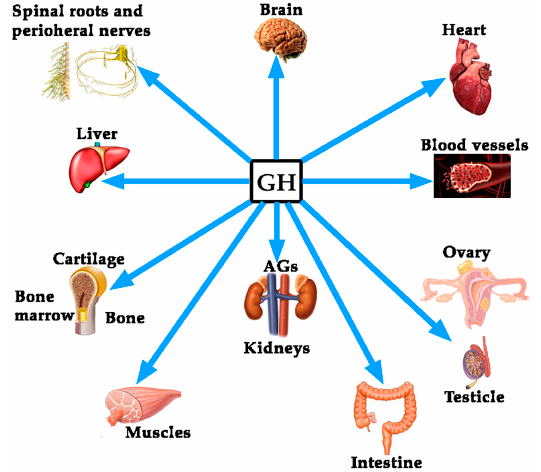
Figure 1. Growth hormone (GH) is a pleiotropic hormone acting on many tissues and organs in the human organism. Blue arrows show some of the most important territories in which the hormone produces positive effects. For a better understanding of this schema, see reference [4]. AGs: Adrenal glands.